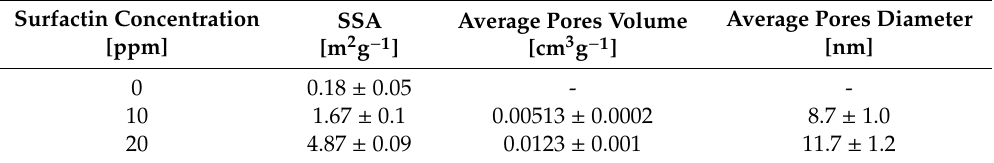
Table 3. The characteristic surface parameters of CaCO 3